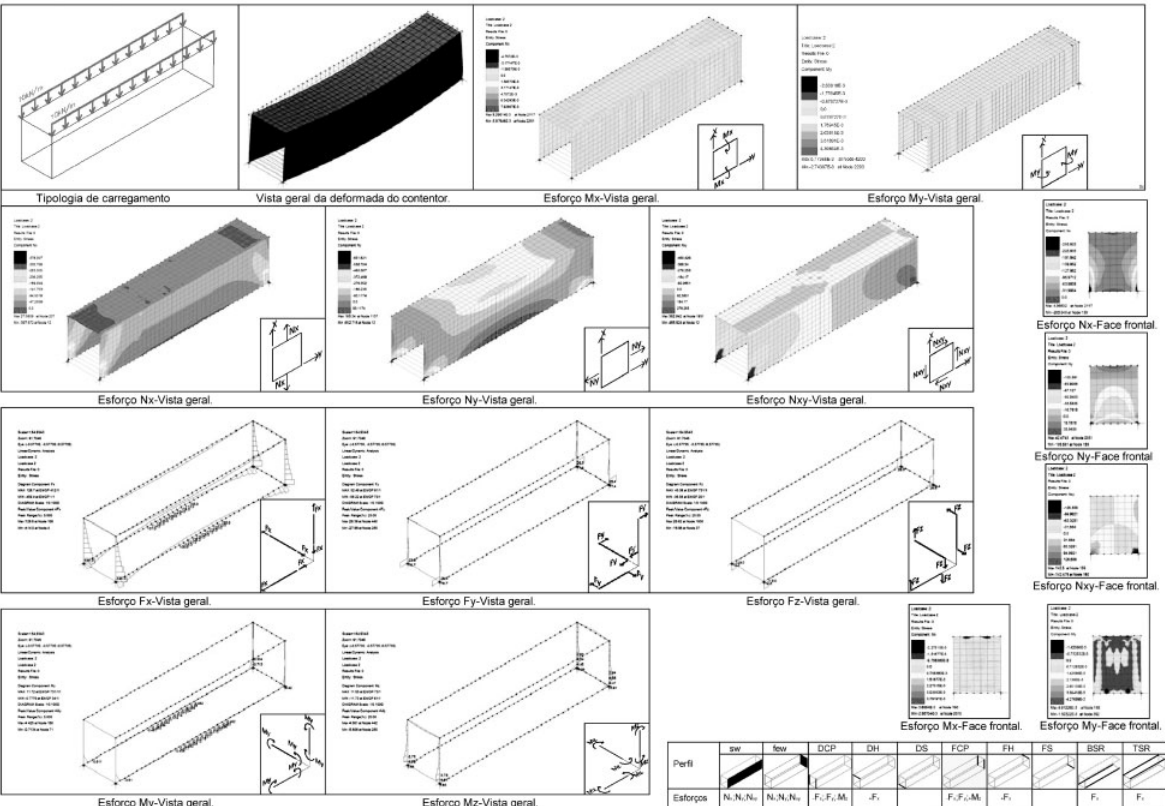
Fig. 6. Results obtained for load case 2 (model 40’HC)